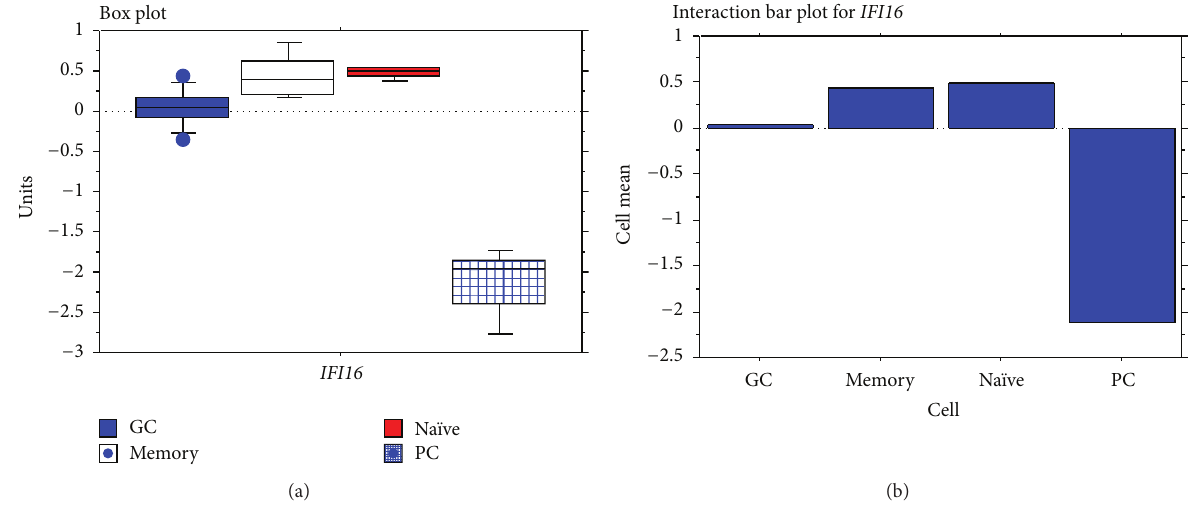
Figure 1: IFI16 mRNA expression in normal B-cell subsets. IFI16 mRNA expression evaluated by GEP and presented in box plot (a) and interaction bar plot (b). Na¨ıve and memory B-cells showed a significantly higher IFI16 mRNA level with respect to GC B-cells (na¨ıve versus GC 𝑝 = 0.0062 ; memory versus GC 𝑝 = 0.0131 ; Mann-Whitney test) and PCs (na¨ıve versus plasma cells 𝑝 < 0.0001 ; memory versus PCs 𝑝 < 0.0001 ; Mann-Whitney test) but no differences were noted between na¨ıve and memory B-cell subsets ( 𝑝 = 0.78 ; Mann-Whitney test). GC cells showed a significant increase with respect to plasma cells ( 𝑝 < 0.0001 ; Mann-Whitney